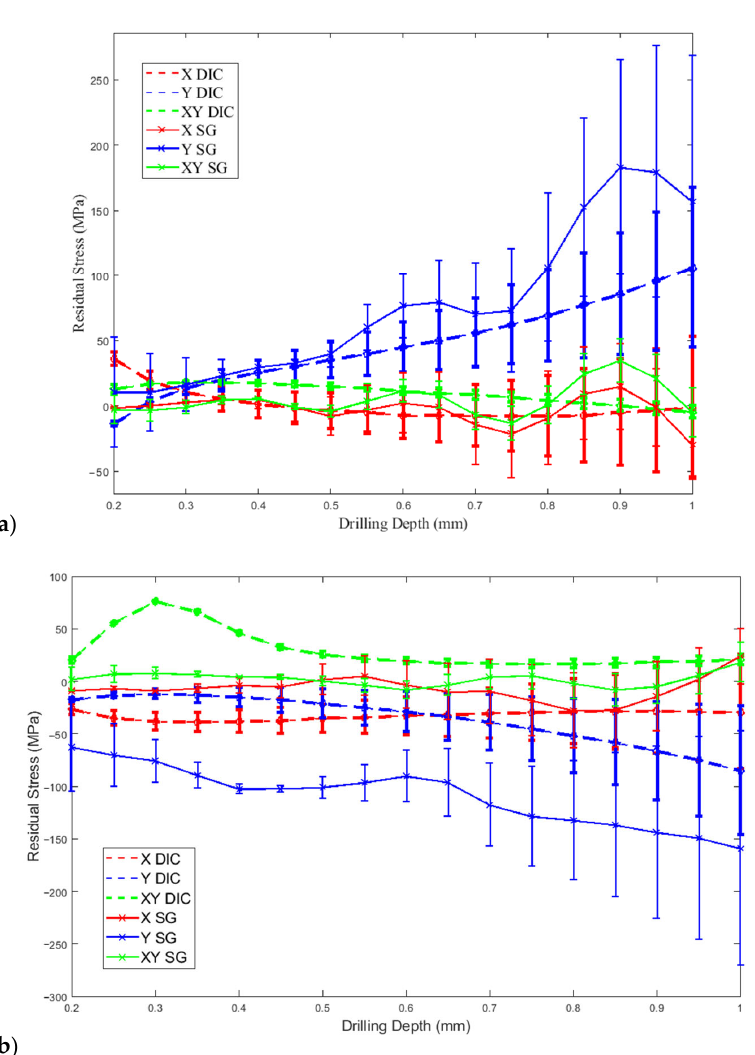
Figure 9. Comparison of DIC and strain-gauge measurements as a function of hole depth at ( a ) point T and ( b ) point C. The error bars represent the 95% confidence intervals of each point.